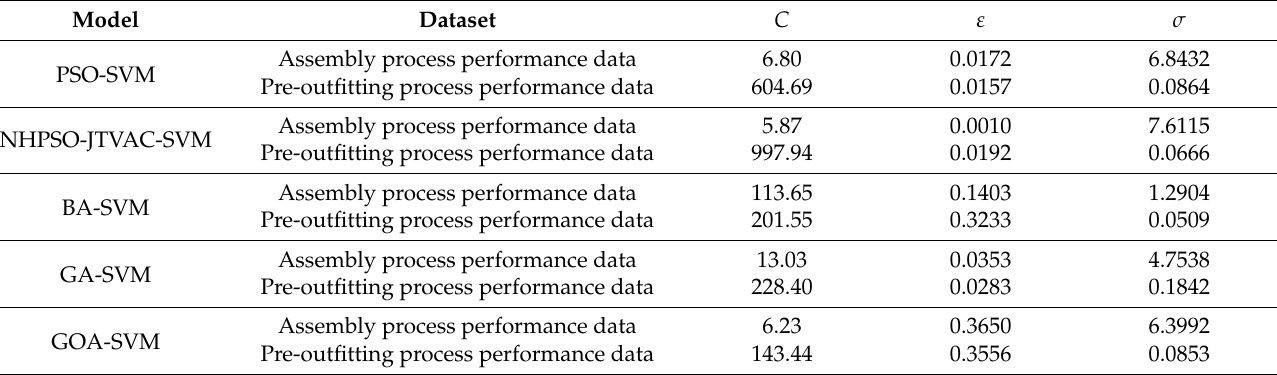
Table 6. Optimal values of the three SVM parameters ( C , ε , and σ ).